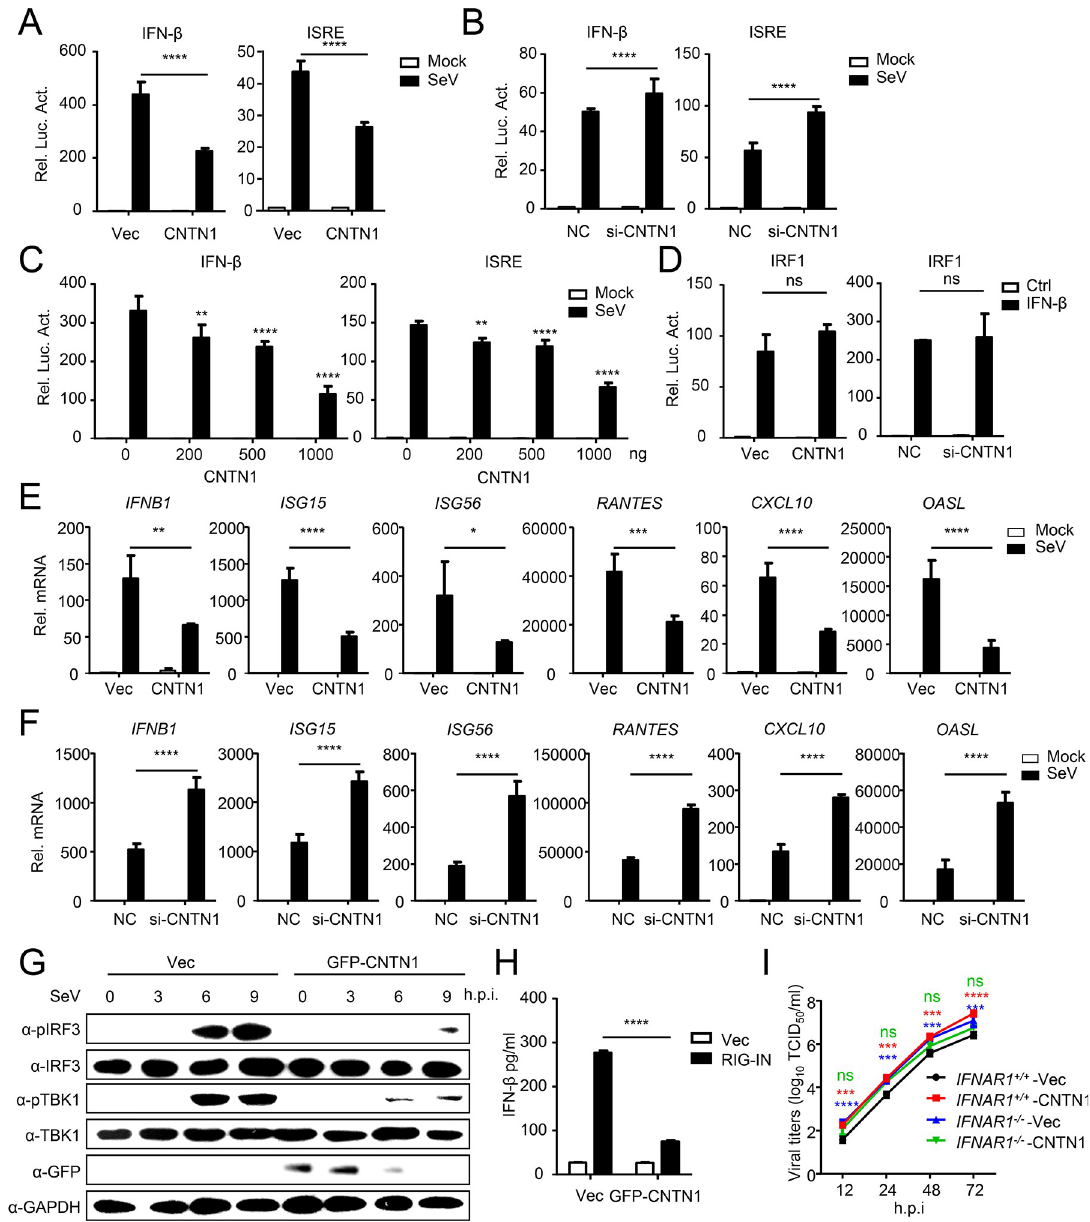
Fig 3. CNTN1 negatively regulates the type I IFN signaling pathway. (A-B) CNTN1 inhibits IFN-related promoter activities. Luciferase reporter plasmids (IFN- β -Luc or ISRE-Luc) and the pRL-TK plasmid were co-transfected into HEK293 cells, along with Flag- CNTN1 or Vec (A) or CNTN1 siRNA or scrambled siRNA (NC) (B). At twenty-four hours after transfection, the cells were left uninfected or were infected with SeV for 12 h before reporter assays. (C) Luciferase reporter plasmids (IFN- β -Luc or ISRE-Luc) and the pRL-TK plasmid were co-transfected into HEK293 cells, along with different concentrations of CNTN1 expression plasmid. At twenty- four hours after transfection, cells were left uninfected or were infected with SeV for 12 h before reporter assays. (D) Luciferase reporter plasmids (IRF1-Luc) and the pRL-TK plasmid were co-transfected into HEK293 cells, along with Flag-CNTN1 or Vec or CNTN1 siRNA or NC. At twenty-four hours after transfection, the cells were left untreated or were treated with IFN- β for 12 h before reporter assays. (E-F) A549 cells were transfected with Flag-CNTN1 or Vec (E) or CNTN1 siRNA or NC (F), and subsequently left uninfected or infected with SeV for 12 h before qPCR analysis. (G) CNTN1 inhibits virus-induced phosphorylation of TBK1 and IRF3. A459 cells were transfected with GFP-CNTN1 plasmid or Vec. At twenty-four hours after transfection, the cells were infected with SeV for the indicated times. Then, immunoblotting analysis were performed with the indicated antibodies. (H) HEK293 cells were transfected with CNTN1 or Vec, and induced by RIG-IN transfection. The concentration of IFN- β in the supernatants was detected by an ELISA. (I) IFNAR1 +/+ or IFNAR1 -/- A549 cells were transfected with the CNTN1 expression plasmid or Vec. Twenty-four hours later, the cells were infected with H5N6 virus at an MOI of 0.01 or 3. At the indicated times post-infection, the supernatant containing viral particles was assessed in the